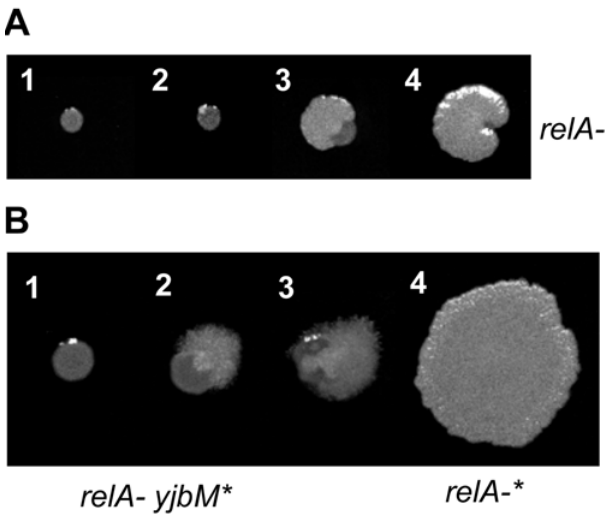
Figure 5. Colony morphologies of spontaneously generated suppressors. A) relA - colonies generate suppressors that engulf the original colonies. 1–4: gradual generation and development of suppressors. B) The yjbM* mutation partially suppresses the relA - growth defect, but these colonies continue to generate suppressor mutations, presumably at genomic loci other than yjbM . 1. relA - yjbM* before other suppressors are generated. 2, 3. relA - yjbM* with new suppressors. 4. relA - with double suppressors ( relA- yjbM* ywaC*